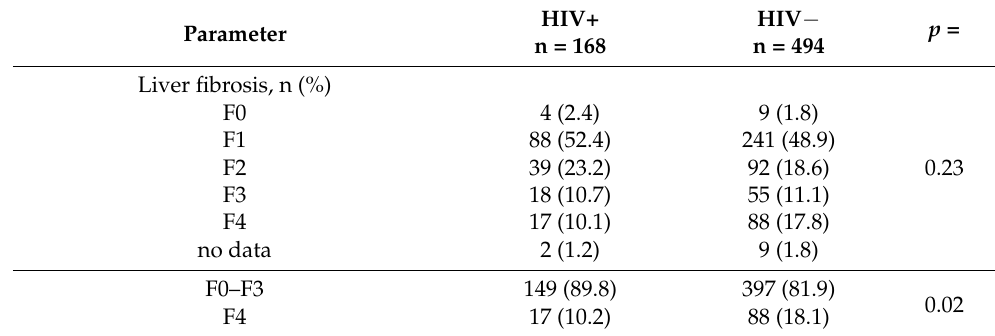
Table 2. Characteristics of the liver disease in GT4-infected patients depending on the HIV